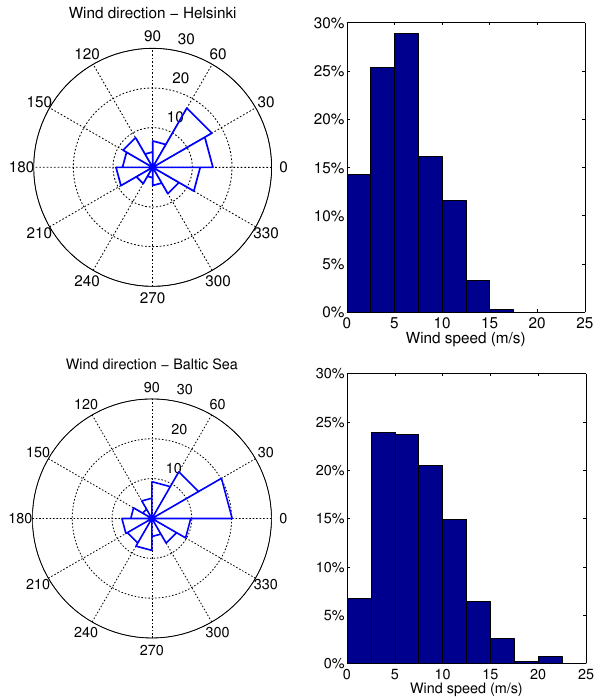
Figure 2. Wind directions (left panels) and wind-speed histogram Fig. 2. Wind directions (left panels) and wind-speed histogram (right panels) averaged below 950hPa level over all summers 2005– (right panels) averaged below 950 hPa level over all summers 2011. The azimuthal angle 0 corresponds to wind from west to east 2005–2011. The azimuthal angle 0 corresponds to wind from west (according to the ECMWF definition). Both the data from Helsinki to east (according to the ECMWF definition). Both the data from and the central Baltic Sea area, as defined by the white boxes in Helsinki and the central Baltic Sea area, as defined by the white Fig. 1, are presented in the upper and lower panels, respectively. boxes in Fig. 1, are presented in the upper and lower panels, respec- tively.